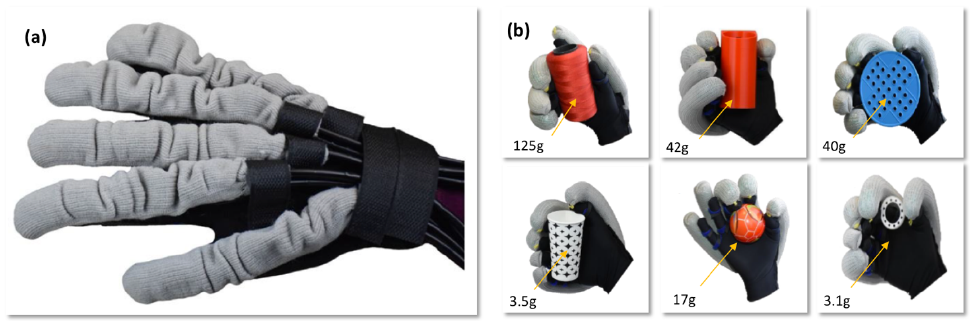
Figure 4. ( a ) Wearable assistive glove prototype based on a seamless knitted actuator. ( b ) Achievable motions with the glove prototype for grasping objects of different weights and